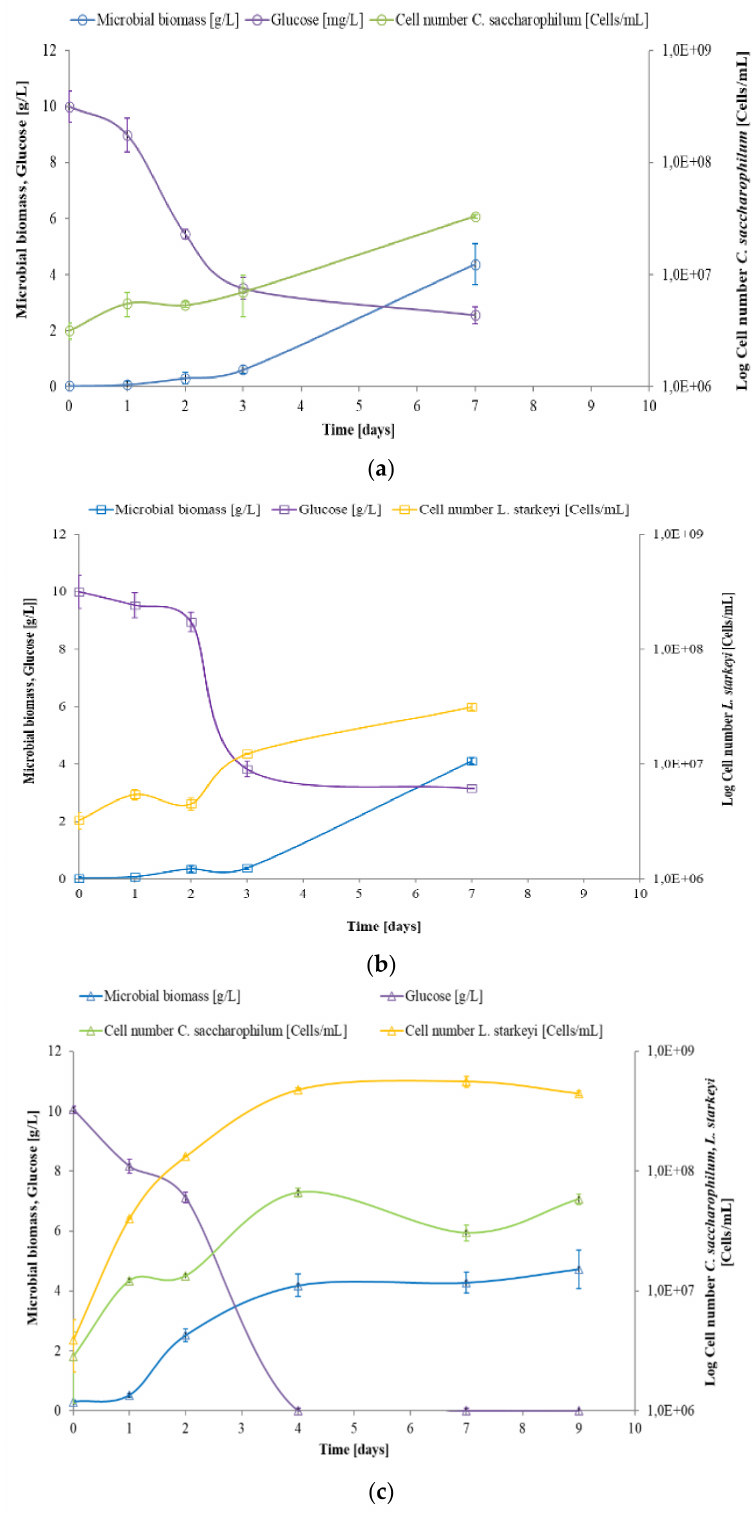
Figure 2. ( a , b ) Profiles of microbial biomass (g/L), glucose consumption (g/L) and cell number (cells/mL) in YEG medium inoculated by C. saccharophilum ( a ) and L. starkeyi ( b ). ( c ) Profiles of microbial biomass (g/L), glucose consumption (g/L) and cell number (cells/mL) in YEG medium inoculated by C. saccharophilum and L. starkeyi in mixed